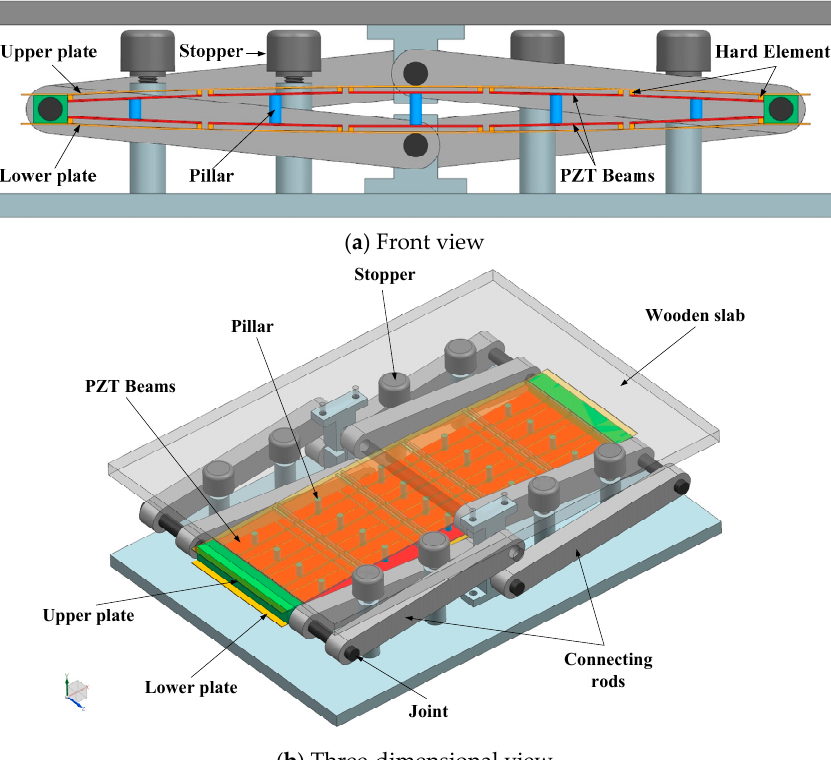
Figure 2. Structure of the energy harvesting floor.